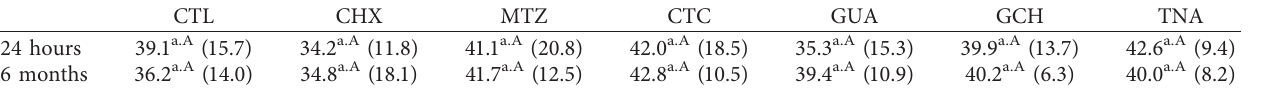
∗ Number of compounds identified in Figure 1. Rt: retention time; RPA: relative peak area. Table 4: Push-out strength means as a function of the evaluation